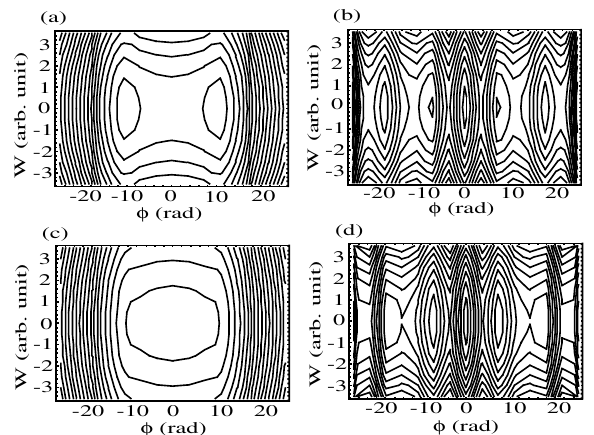
FIG. 5. Contour of the Hamiltonian for (a) the superbunch beam; (b) the rf-bunch beam before the transition energy; (c) the superbunch beam; (d) the rf-bunch beam after the (cid:4) 4 (cid:14) (rad); k (cid:4) (cid:5) 0 : 43 (cid:1) kV =(cid:22) s (cid:2) . FIG. 6. V 0 (solid line) and the kinetic energy (dashed transition energy. (cid:23) 0